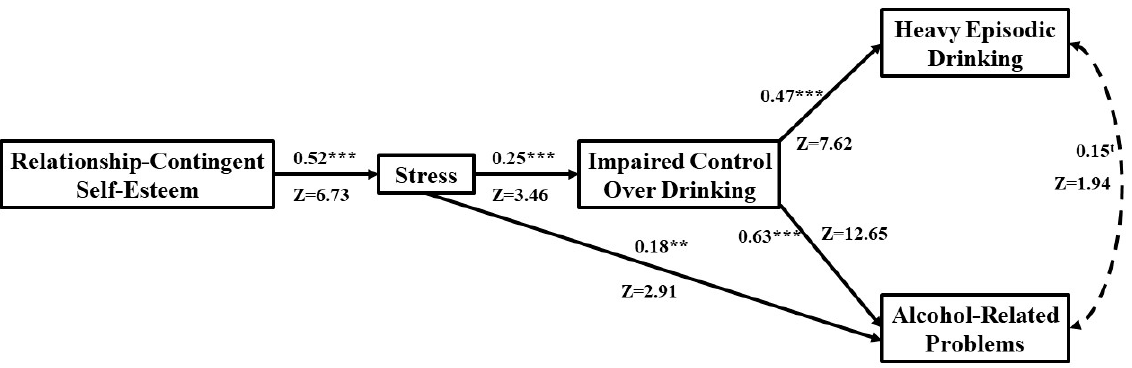
Figure 2. Fit path model for women, N = 193. Standardized coefficients are shown for women: t = trend at p = 0.052; ** p < 0.01; *** p < 0.001.